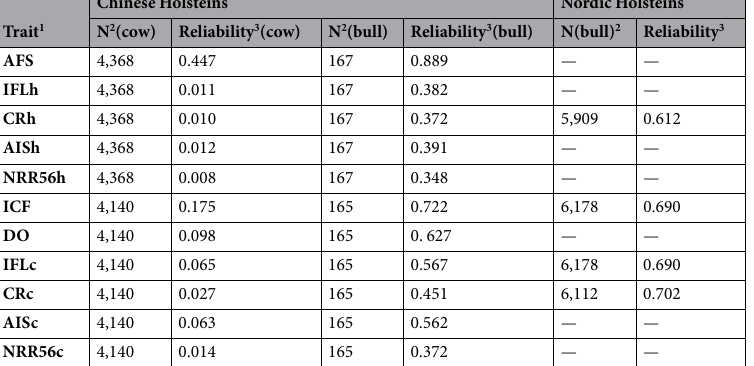
— — Table 1. Number of animals and average reliabilities of pseudo phenotypes for female fertility trait in Chinese and Nordic Holsteins. 1 AFS = age at first insemination; IFL = interval from first to last insemination; CR = conception rate at first insemination; AIS = number of inseminations per conception; NRR56 = non- return rate at 56 d after first insemination; ICF = interval from calving to first insemination; DO = days open. For the traits expressed in both heifers and cows, a suffixes h (for heifers) or c (for cows) was attached to the trait abbreviations. 2 The number of animals. 3 The average reliability of pseudo phenotypes (yield deviation for cows, daughter yield deviation for Chinese bulls and de-regressed proof for Nordic